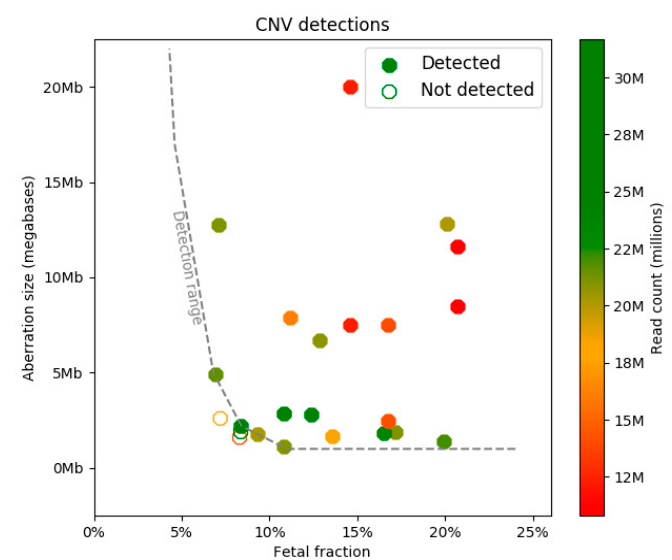
Figure 2. Detection sensitivity based on the fetal fraction and aberration size. Full markers depict the detected samples, while the empty ones represent the non-detected samples. The dashed gray line shows the estimated detection range. Table 2. Evaluation of Copy Number Variation (CNV)